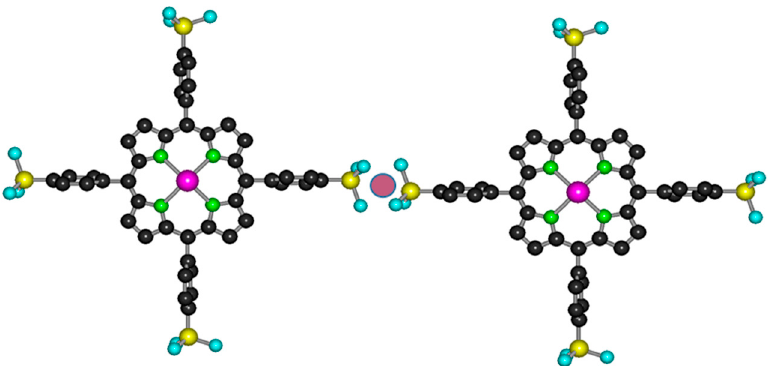
Figure 5. Tail-to-tail connection through the sulfonato groups in lanthanide(III) bisporphyrin. (The hydrogen atoms are omitted for clarity.)